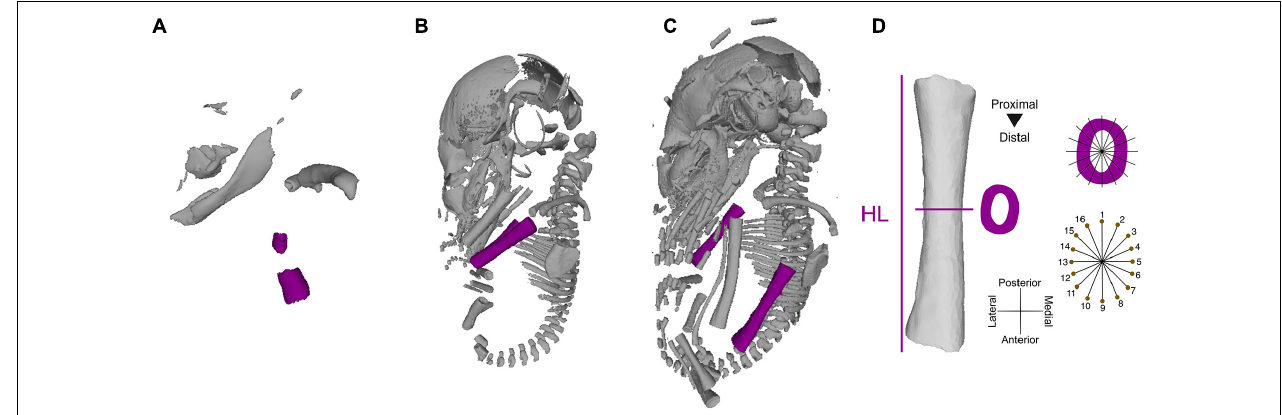
FIGURE 1 | 3D virtual models of ontogenetic series of Rhinolophus thomasii , representing the samples from which raw measurements were taken. Stage 1 (A) , stage 6 (B) , and stage 9 (C) . Landmarking and measuring protocol used to quantify humeral length (HL) and cortical thickness (D) .